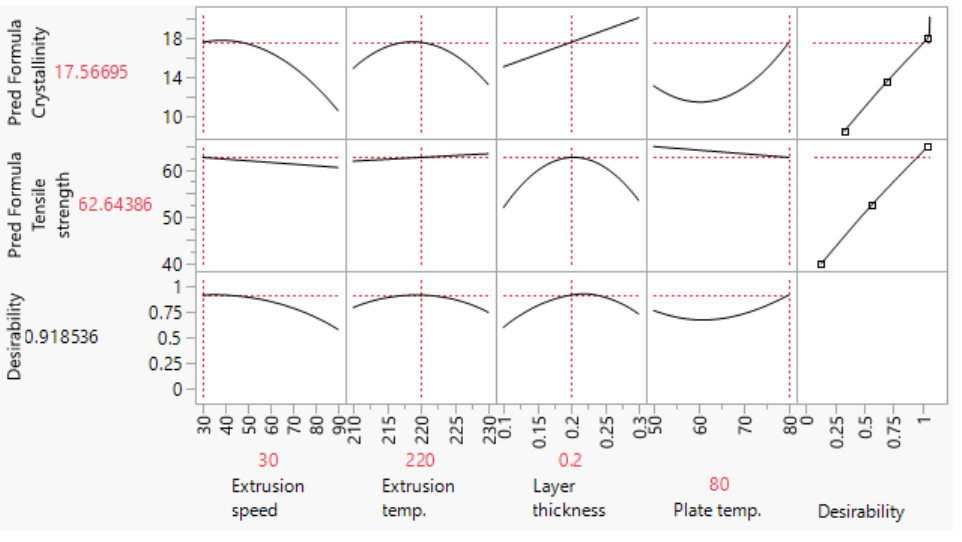
Figure 2. Optimization profiler showing FFF parameter settings which allow fabrication of scaffolds with high-level crystallinity (HLC) and high tensile strength. Table 1. Main processing parameters used for the FFF extrusion of LLC and HLC